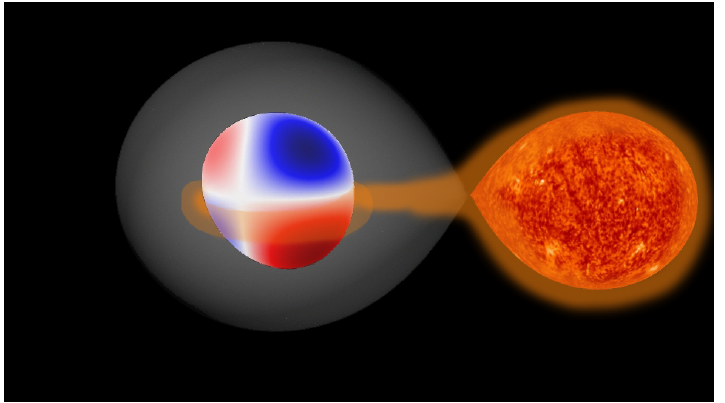
Figure 1. A simulation of the Algol system RZ Cas in accordance with its binary parameters and the primary component’s nonradial pulsations. The primary, which is also the mass-accreting component, is inside its Roche lobe, while the secondary fills its Roche lobe. A superposition of three pulsation modes with l,m = 2,1, l,m = 3,2, and l,m = 1,0 at the surface of the primary is